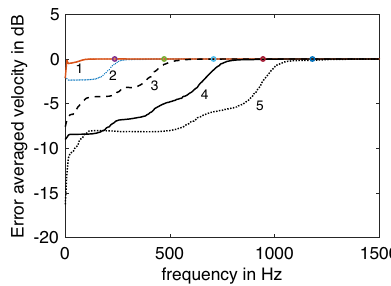
Figure 16. Error in the averaged velocity between original and reconstructed source distribution. Circles indicate the critical frequencies as described in Table 1. The numbering of the curves corresponds to N p